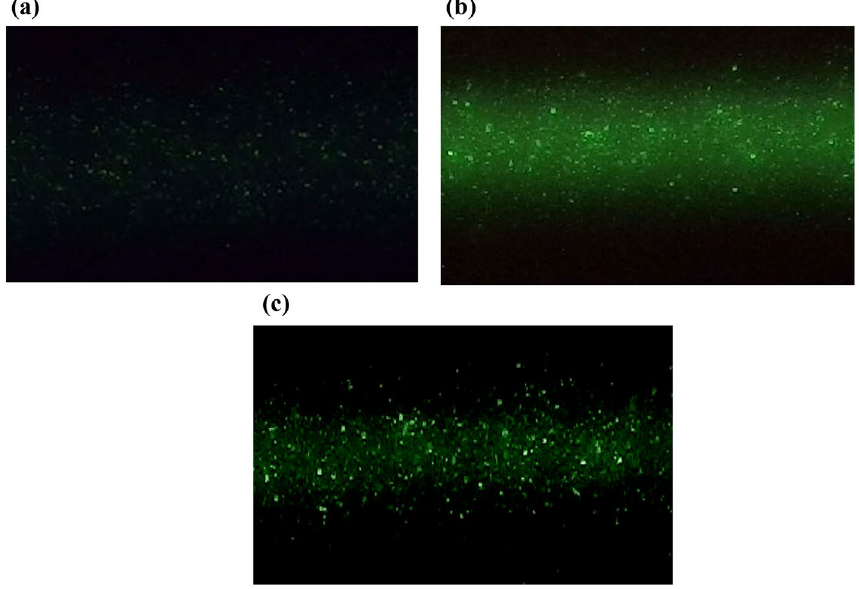
Figure 5. Images of light scattering by 40 nm SiO 2 particles suspended in water. ( a ) Under the condition that water light scattering is barely visible. Incident laser power is 3 mW and the image of pure water is shown in Fig. 2(a). ( b ) Under the condition that the image of light scattering is clearly visible. Incident laser power is 15 mW. ( c ) Under the same condition as the ( b ), but the water light scattering is filtered out through an image sensor